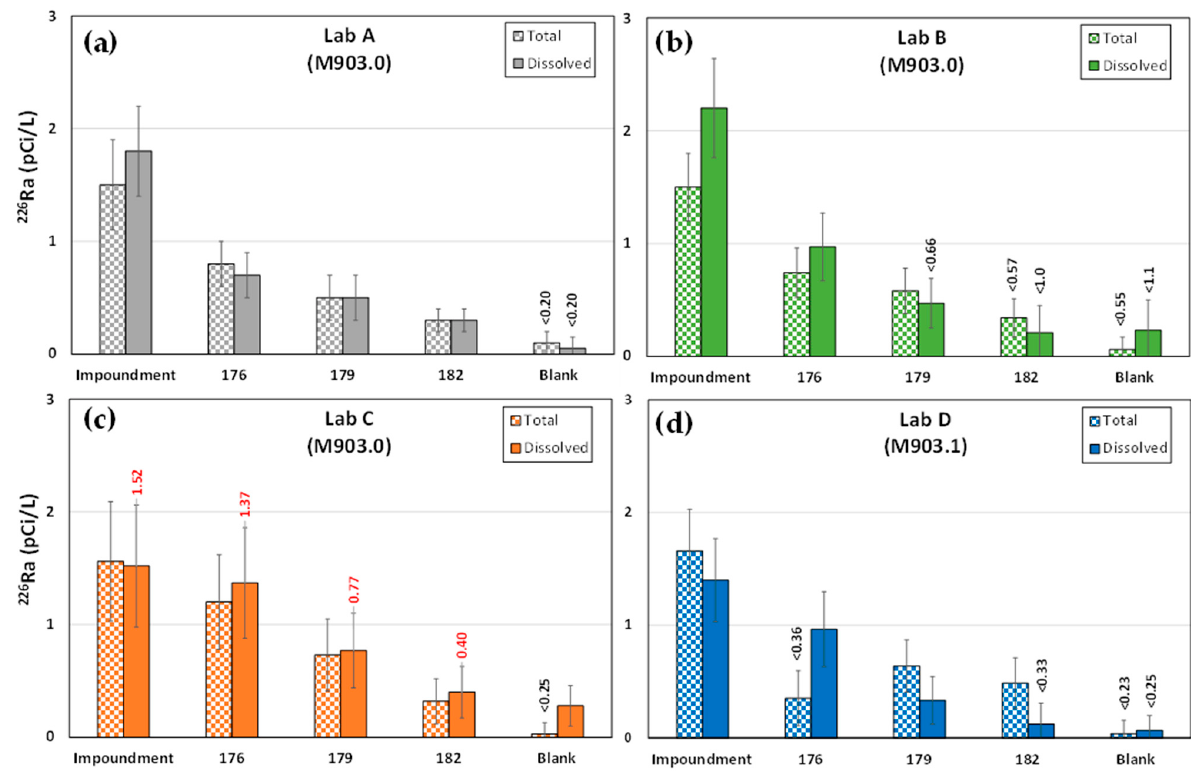
Figure 6. Comparison of total and dissolved 228 Ra concentrations: ( a ) Lab A; ( b ) Lab B; ( c ) Lab C; ( d ) Figure 5. Comparison of total and dissolved 226 Ra concentrations: ( a ) Lab A; ( b ) Lab B; ( c ) Lab C; Lab D. ( d ) Lab D.